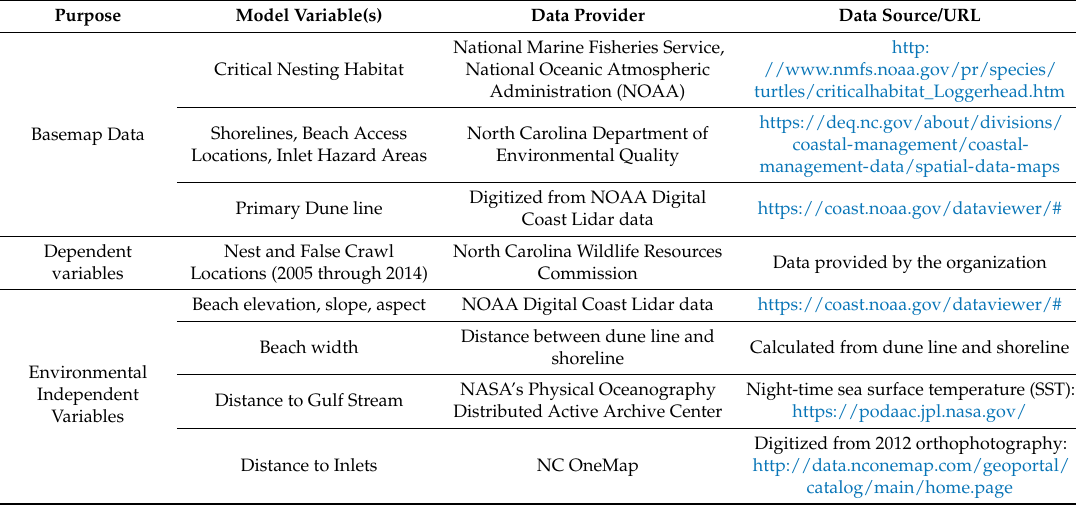
Table 1. Data sources and purpose for model development.